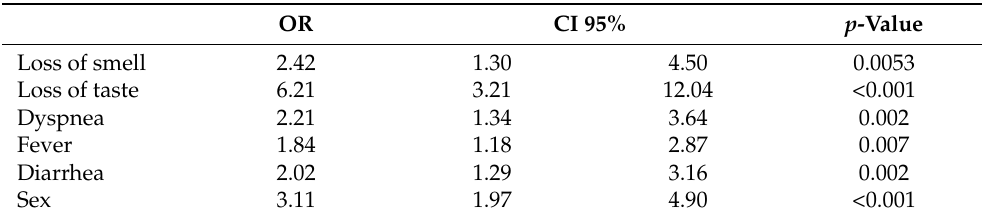
Table 3. Odds ratios (OR), 95% confidence intervals and p -values obtained for the step-wise multi- variate logistic regression model under BIC